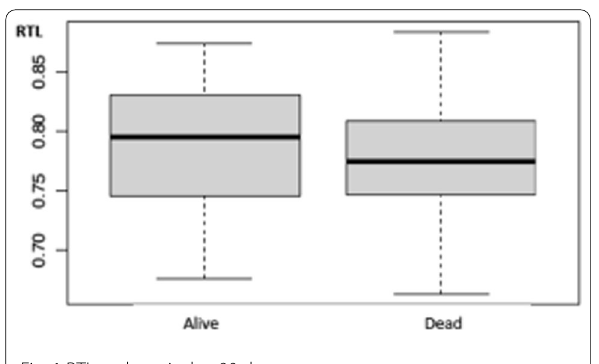
Fig. 1 RTL and survival at 90 days